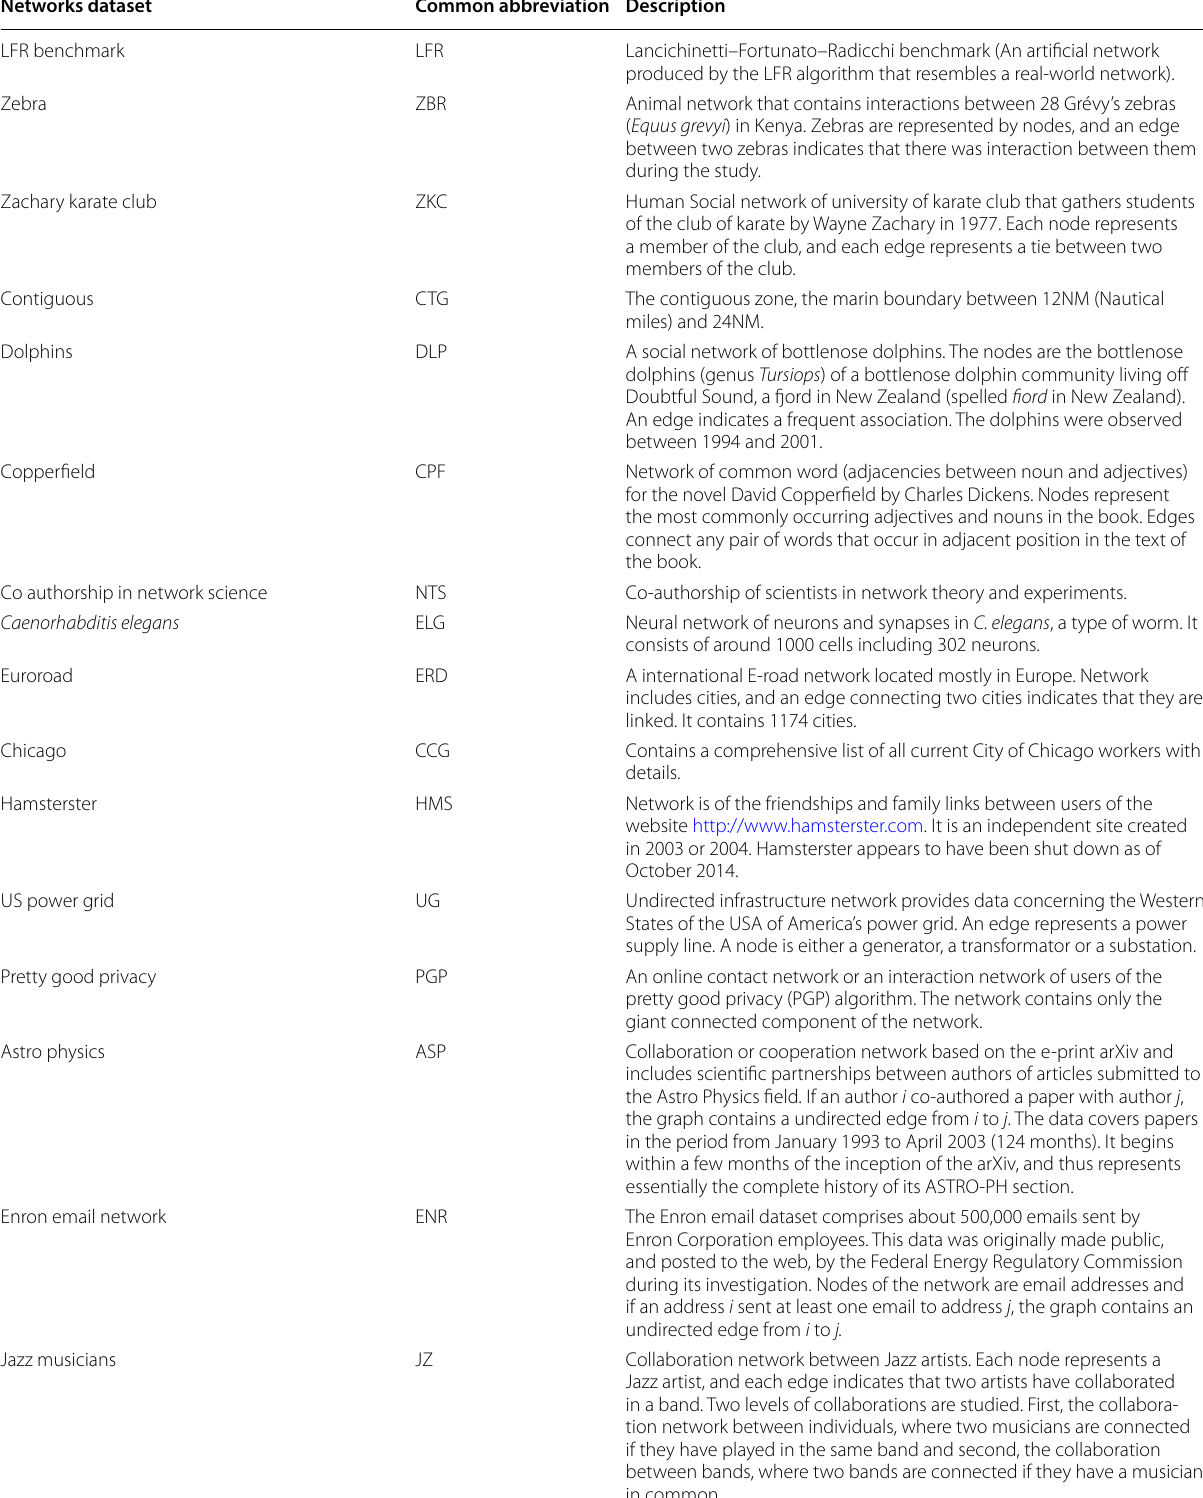
Table 2 Operational network datasets implemented in the main comparison’s referred research Networks dataset Common abbreviation